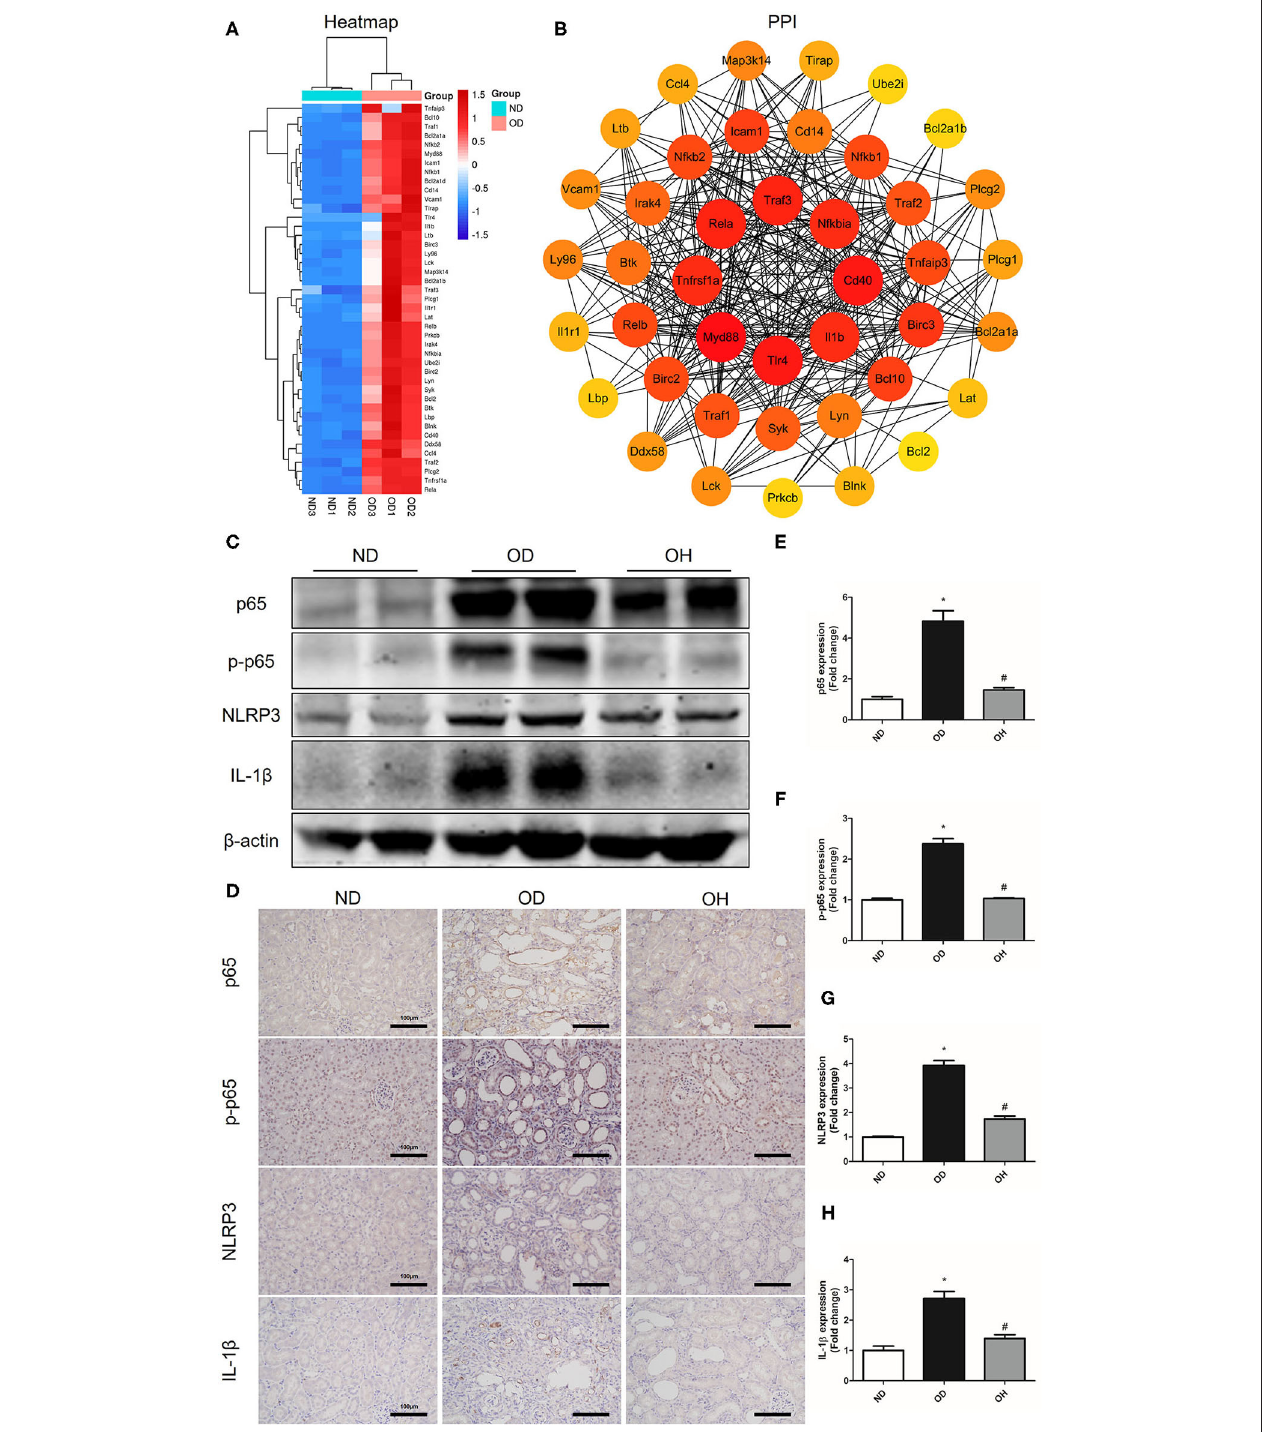
FIGURE 6 | HRW administration suppresses oxalate-induced NF- κ B signaling pathway activation in mice. (A) Heatmap and hierarchical clustering showing DEGs enriched in the NF- κ B signaling pathway between the OD and ND groups. (B) PPI network constructed by DEGs enriched in the NF- κ B signaling pathway. (C) The protein expressions of NF- κ B p65, p-NF- κ B p65, NLRP3 and IL-1 β in kidneys of mice were detected by western blotting. (D) The protein expressions of NF- κ B p65, p-NF- κ B p65, NLRP3 and IL-1 β in kidneys of mice were detected by immunohistochemistry (Scale bar = 100 µ m). (E–H) Corresponding semiquantitative analysis of NF- κ B p65, p-NF- κ B p65, NLRP3, and IL-1 β immunohistochemistry staining. The results were expressed as mean ± SEM. Statistical comparisons were performed using a NewmanKeuls test (* p < 0.05 vs. ND group, # p < 0.05 vs. OD group).